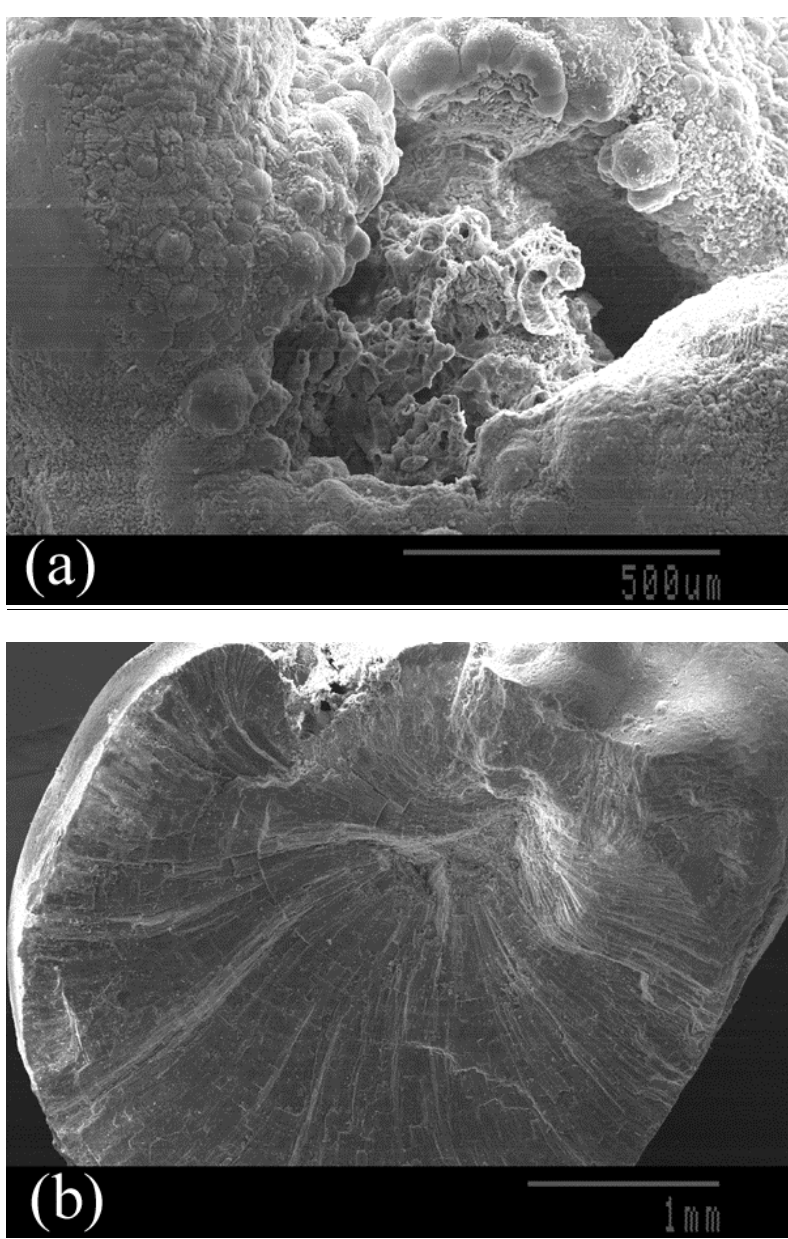
FIGURE 1. Scanning electron microscopy images of a COM papillary calculi. (a) Detail of the point of attachment to the renal papillae, in which calcified renal tubules can be observed; (b) general view of the section of the calculus in which the excentrical core located near the point of attachment to the papillae and a radially striated compact peripheral layer can be seen.